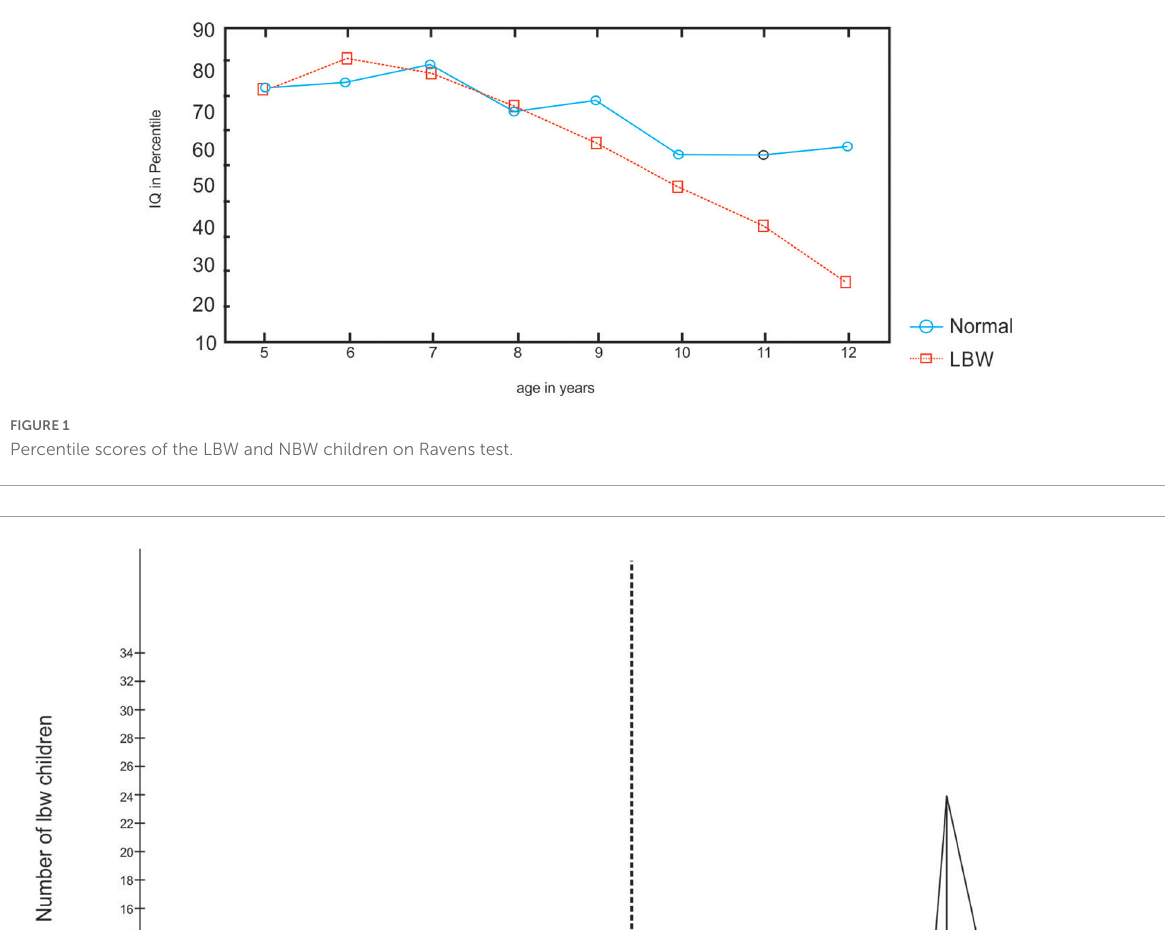
LBW are faster than the NBW for sorting with their left and right hands ( p < 0.05), whereas LBW are slower than the NBW in the bimanual task at all ages ( p < 0.05) (refer to Figure 4 ). In the bimanual task, the envelope was held in the right hand by ten LBW children, while the picking and sorting were done with their left hands. Among the NBW children, the envelope was held in the right hand by eight children, while the picking and sorting were done with their left hands. The remaining children held the envelope in their left hands and sorted with their right hands. The